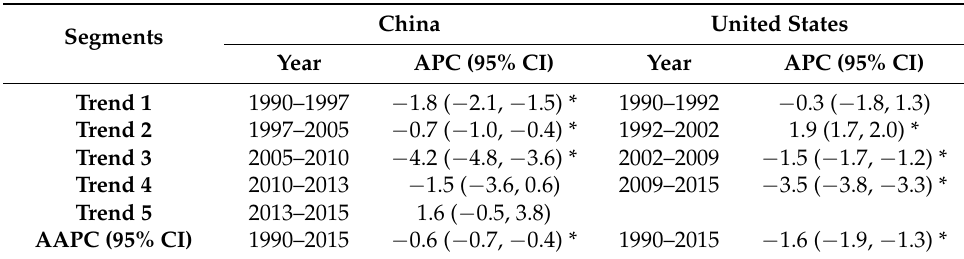
Table 1. Annual percent change in road injury mortality rates for China and the United States,